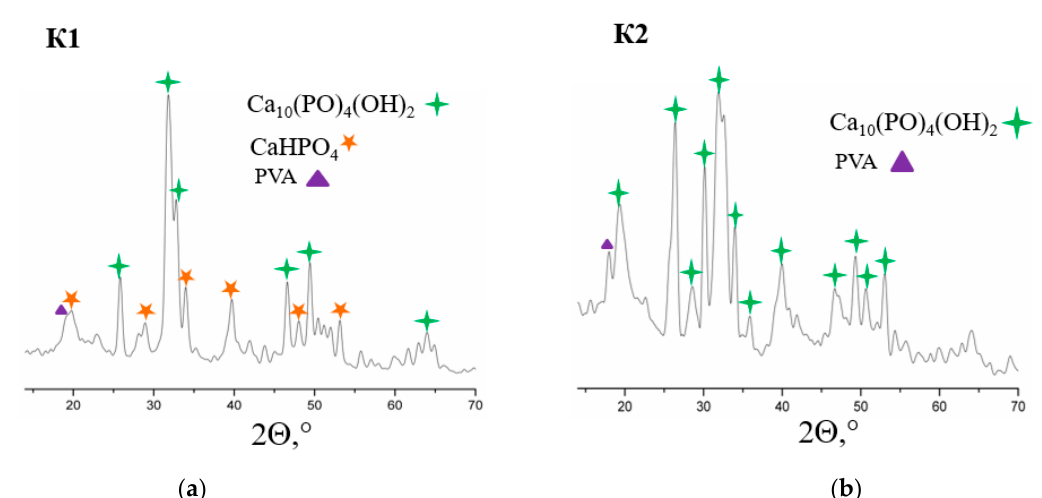
Figure 2. X-ray diffraction patterns of samples of composites K1 ( a ) and K2 ( b ).